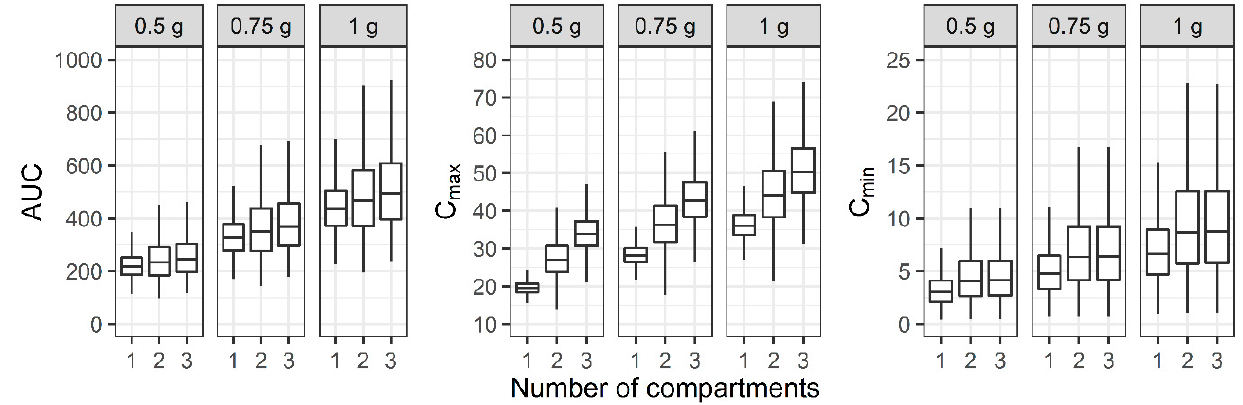
Figure 5. Distribution of area under the curve over 24 h (AUC), maximum concentration (C max ), and minimum concentration (C min ) at steady state when one-, two-, and three-compartment models were developed with three-compartment PK profile and sparse or dense sampling designs (dashed lines, typical parameter values used for simulation; horizontal line inside the box, median; ends of each box, upper and lower quartiles; whiskers, 1.5 × quartiles). For the three-compartment PK profile, the probability of an AUC/MIC of <400 for the reduced one-, two-, and three-compartment models was 35.6, 32.7, and 25.8%, respectively, when a regimen of 1 g IV infusion over 1 h every 12 h was administered and the MIC was 1 mg/L. In the case of an AUC/MIC of 400 to 600 considering efficacy and safety simultaneously, the probability for the one-, two-, and three-compartment models with the same regimen was 58.8, 45.1, and 47.7%. The probability of an AUC/MIC of >600 for the one-, two-, and three-compartment models was 5.56, 22.2, and 26.6%, respectively, when vancomycin was administered with the same dosage regimen (Table 4). Table 4. Probability of target attainment (%) for three PK/PD indices of vancomycin when one-, two-, and three-compartment models were developed with 10,000 three-compartment PK profile and sparse or dense sampling designs.